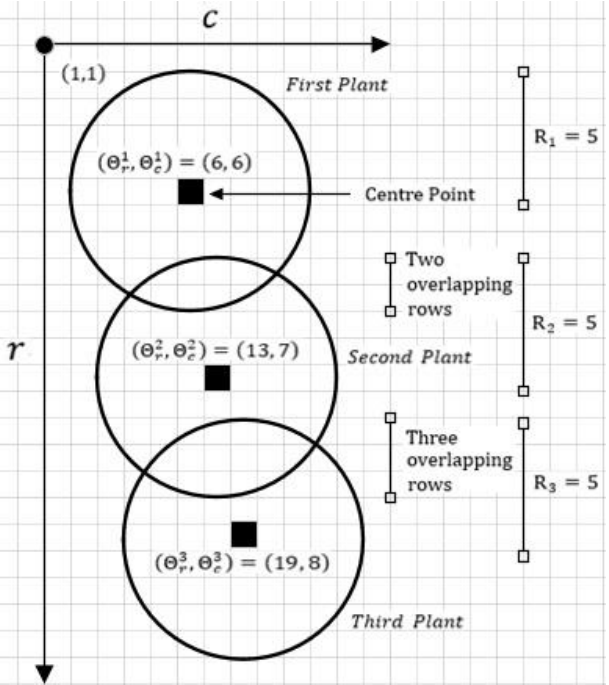
Figure 11. Three plants in a crop row overlapping at top and bottom positions. The center points and radii are also mentioned, which assist in extracting overlapping rows.